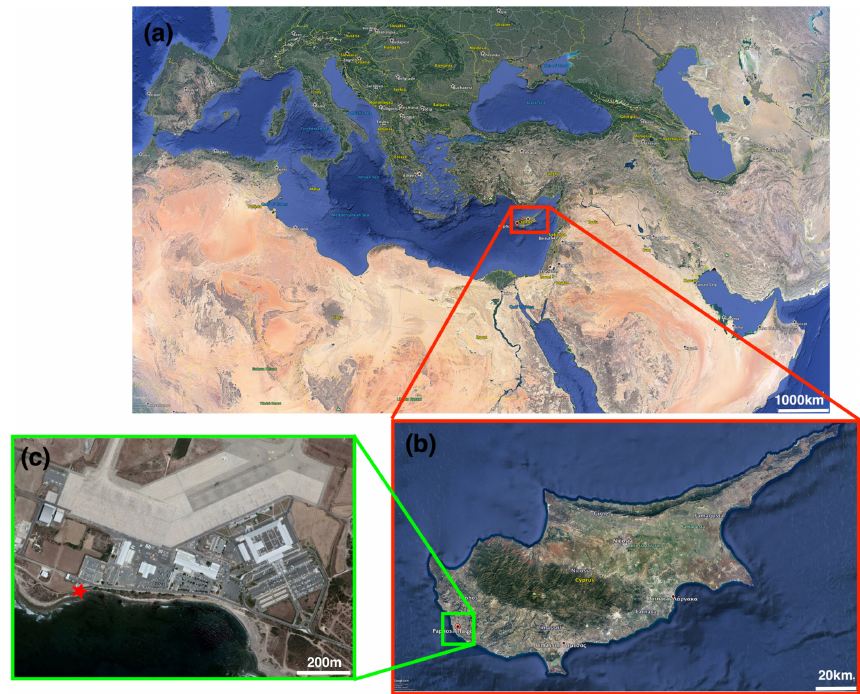
Figure 1. Maps of the Mediterranean region, Cyprus, and the sampling location. (a) Position of Cyprus in the Mediterranean region. (b) Po- sition of Paphos in Cyprus. (c) The sampling site is displayed as a red star. Northeast of the sampling site is Paphos International